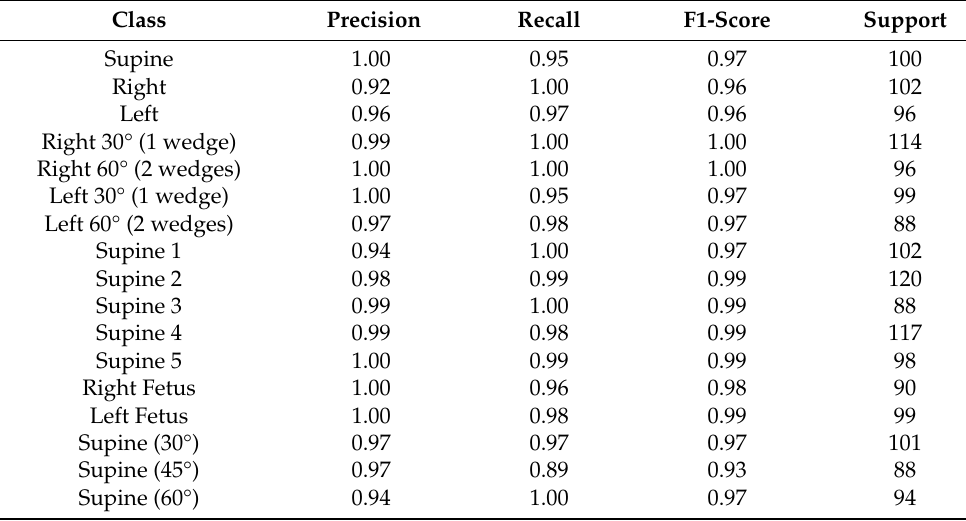
Figure 5. Medilogic Seat Pressure Measurement System; Right: the imposed sampling scheme. The clear dots are the selected sensors. Table 3. Accuracy results of the FCN for all the laying